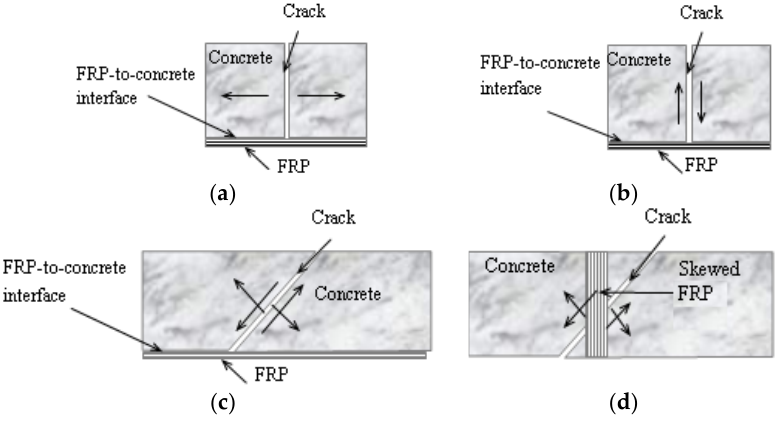
Figure 1. Debonding of fiber reinforced polymer (FRP)-to-concrete interfaces in bond critical applications: ( a ) mode II failure; ( b ) mode I failure; ( c ) Mixed-mode failure; ( d ) Debonding of skewed FRP.